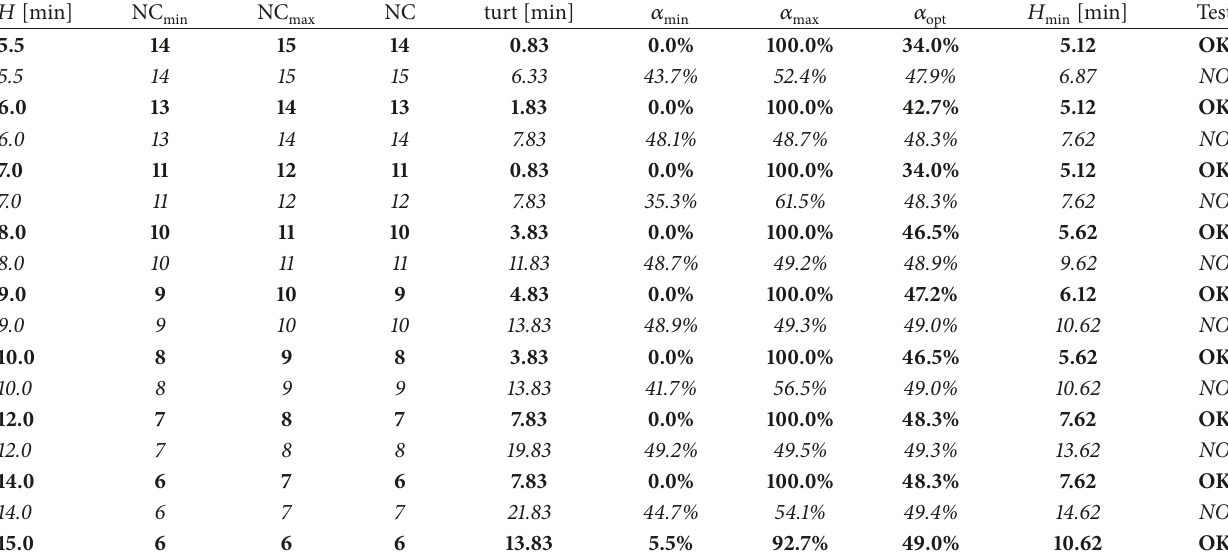
Table 4: Feasible configuration calculation in the case of the 95th